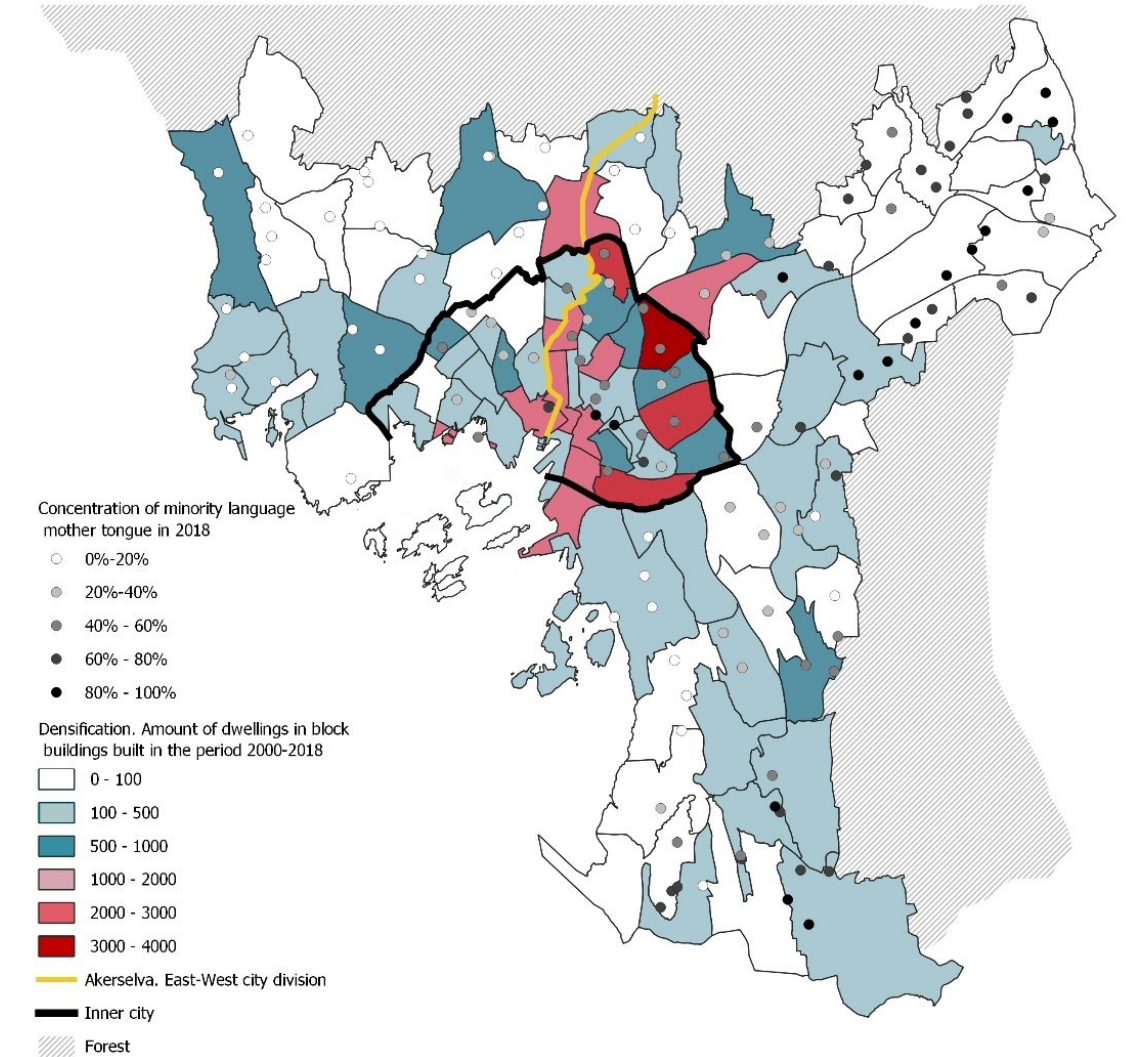
Figure 3. Densification and school ethnic composition. Source: Authors’ elaboration on data provided by Oslo Statistikkbanken (2018c,